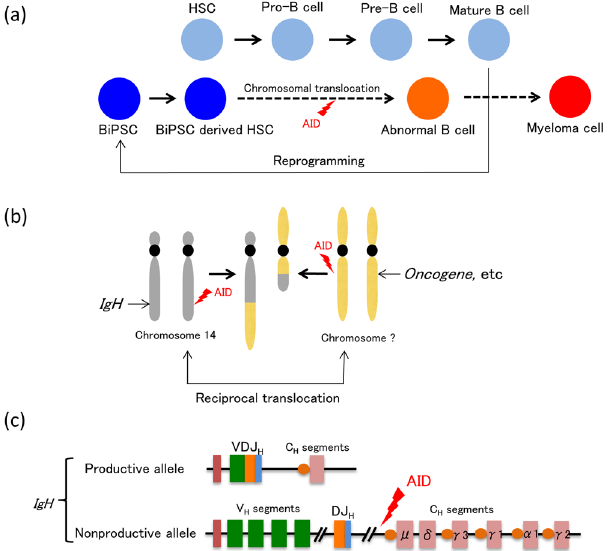
Figure 7. Abnormal B cells as the origin of myeloma cells (hypothesis). When expression of Yamanaka factors is induced for any reason in mature B cells, the cells are reprogrammed and B cell derived iPS cells (BiPSCs) are established ( a ). During the process of redifferentiation of these BiPSCs into hematopoietic stem cells and further into B cells, cleavages occur on chromosome 14 and another chromosome due to AID expression, resulting in the formation of abnormal B cells ( a ) with reciprocal translocation of these chromosomes ( b ). One of the alleles of the IgH gene of these B cells is a productive (functional) allele that had performed